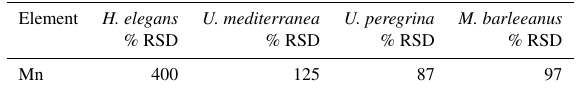
Table 5. Relative standard deviation (% RSD) of interindividual values in Mn / Ca within four species of benthic foraminifera (